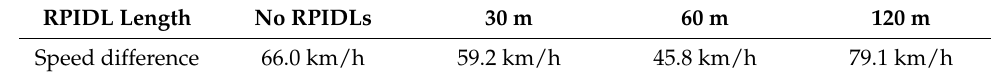
Table 1. Difference between maximum and minimum vehicle speeds with and without RPIDLs.